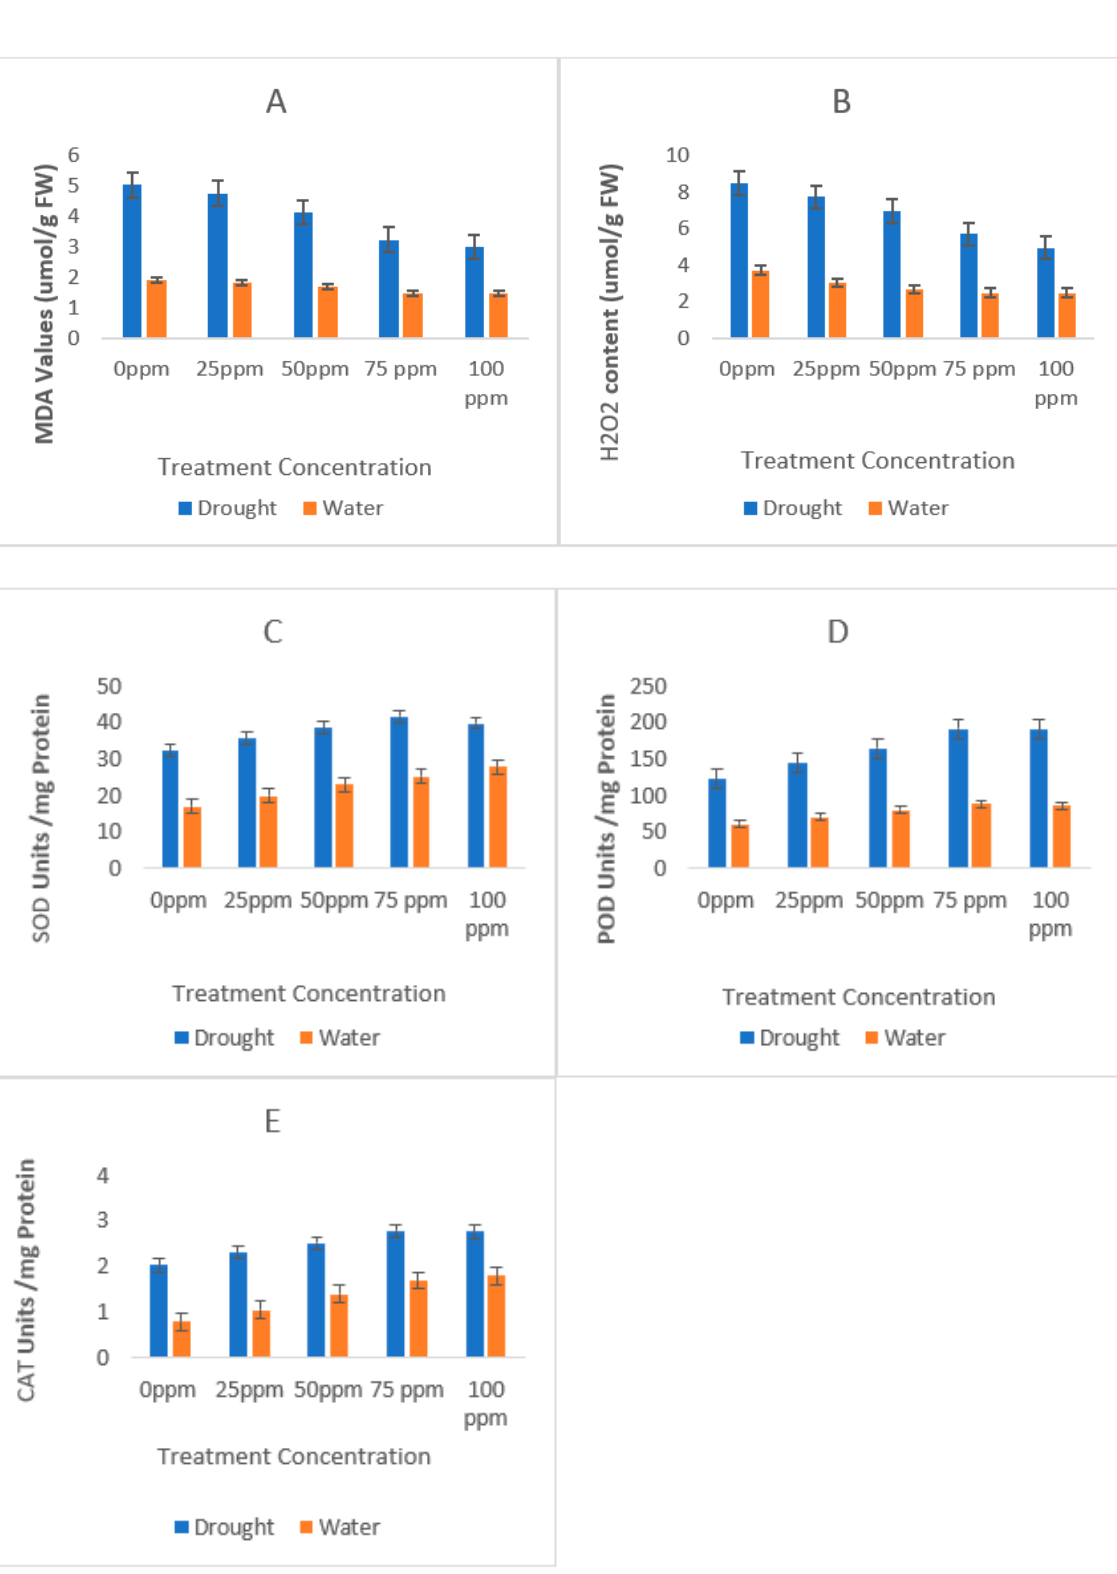
Figure 4. Values of osmotic stress indicators and antioxidant enzymes activities in flax plants ( A ) Mal- ondialdehyde contents. ( B ) Hydrogen peroxide levels. ( C ) Superoxide dismutase. ( D ) Peroxidase. ( E ) Catalase activities. As influenced by various treatment levels of IONPs under water-scarce and well-irrigated environment (mean ± SE; n =